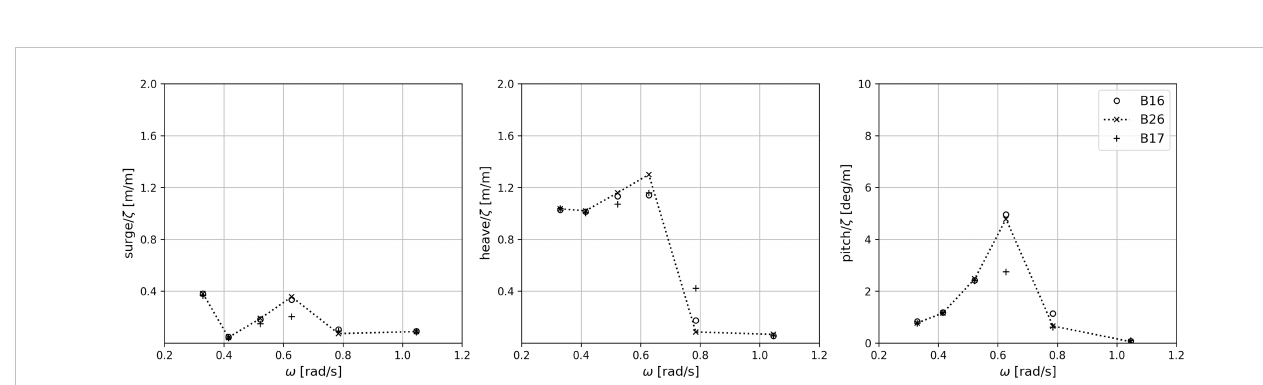
FIGURE 12 RAOs in surge, heave and pitch of the interested fl oating modules in head seas.